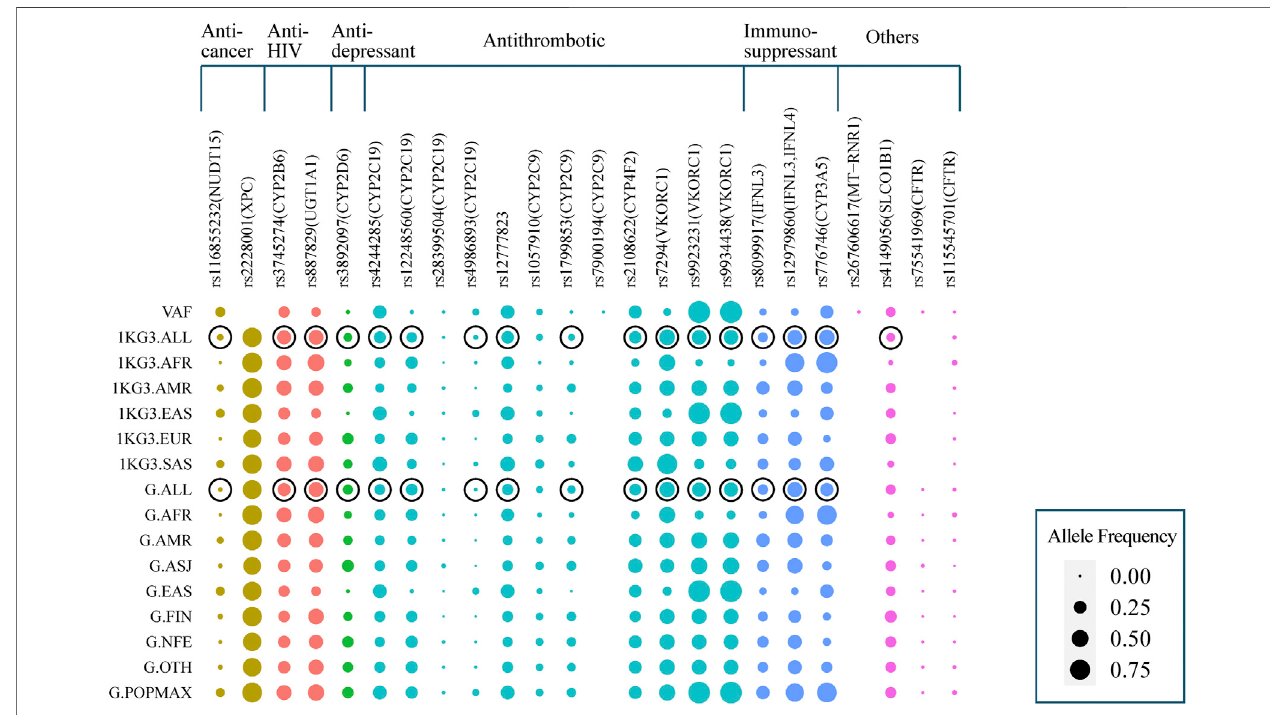
Frontiers in Pharmacology |